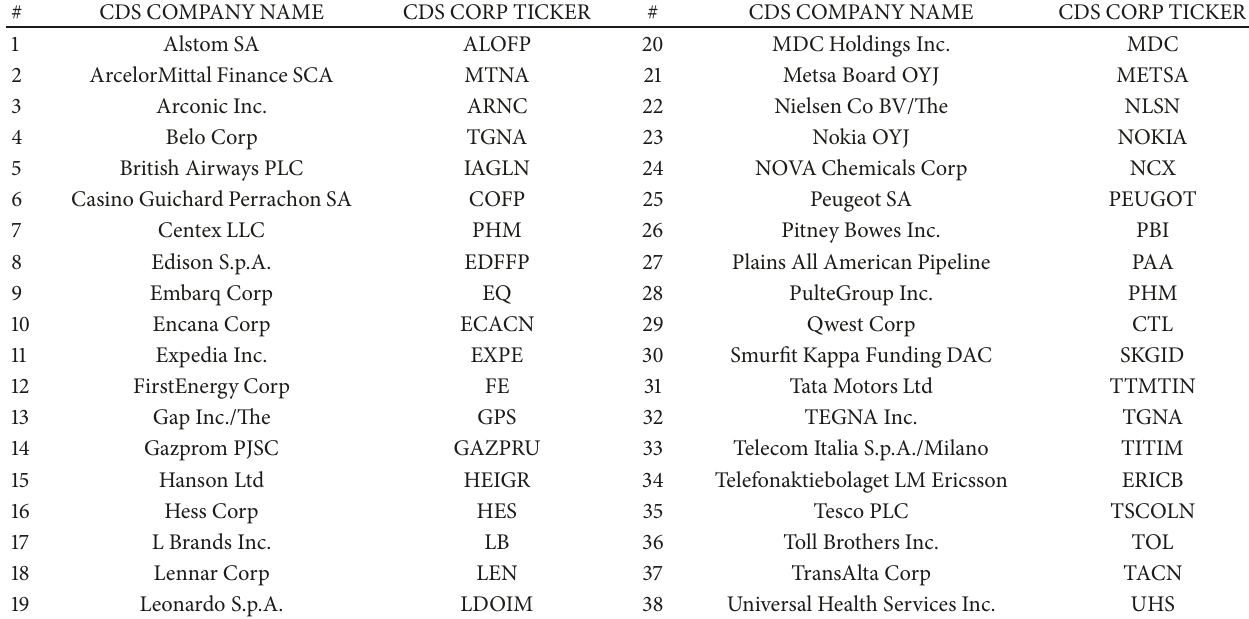
Table 8: Companies used for the HY BB+